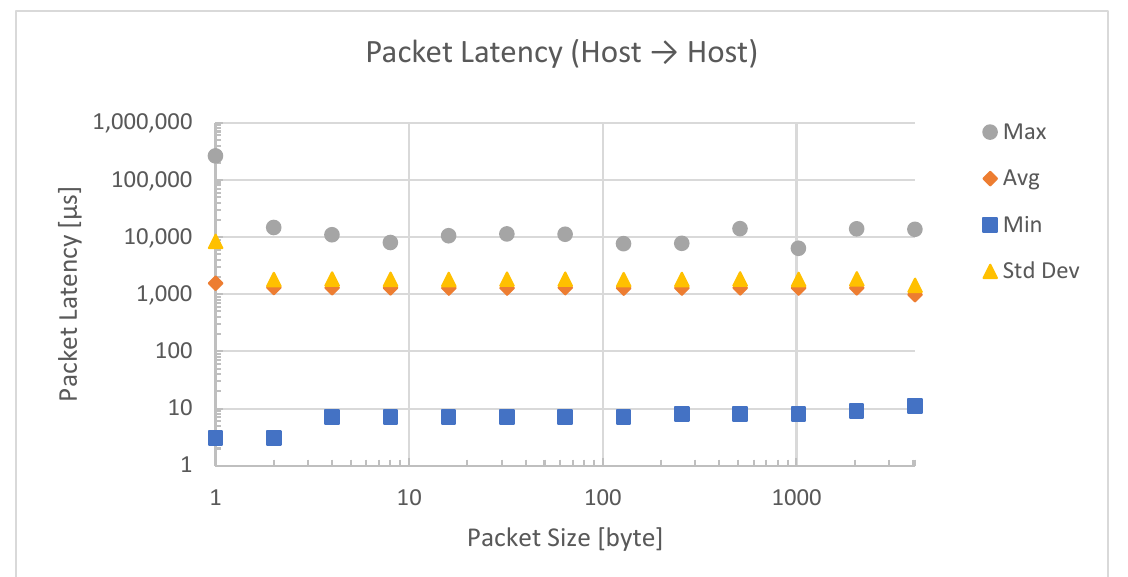
Figure 7. Maximum data rate for packages from 1 to 4096 bytes. For a direct connection, the latency, as shown in Figure 8, is almost constant for pack- age sizes from 2 to 4096 bytes. The large deviation for small packet sizes of 1 byte can be explained by the high frequency of function calls that make interruptions visible to the host operating system.